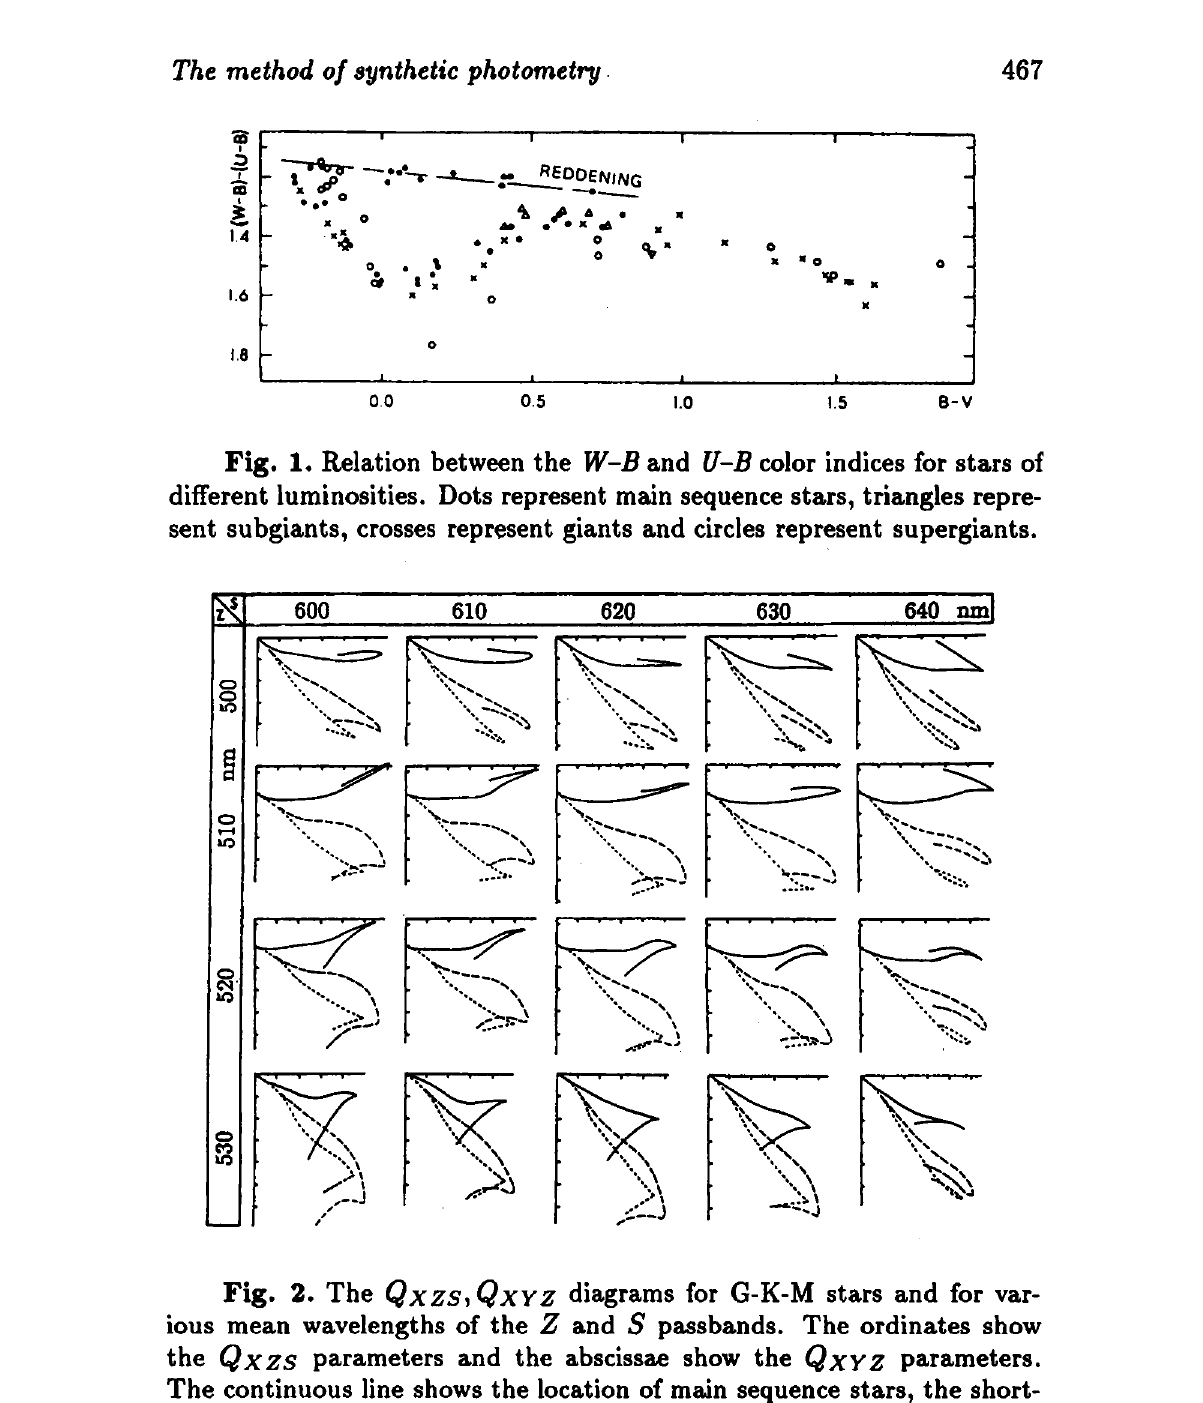
Fig. 2. The QXZSÌQXYZ diagrams for G-K-M stars and for var- ious mean wavelengths of the Ζ and S passbands. The ordinates show the Qxzs parameters and the abscissae show the QXYZ parameters. The continuous line shows the location of main sequence stars, the short- dashed line shows the location of giants and the long-dashed line shows the location of